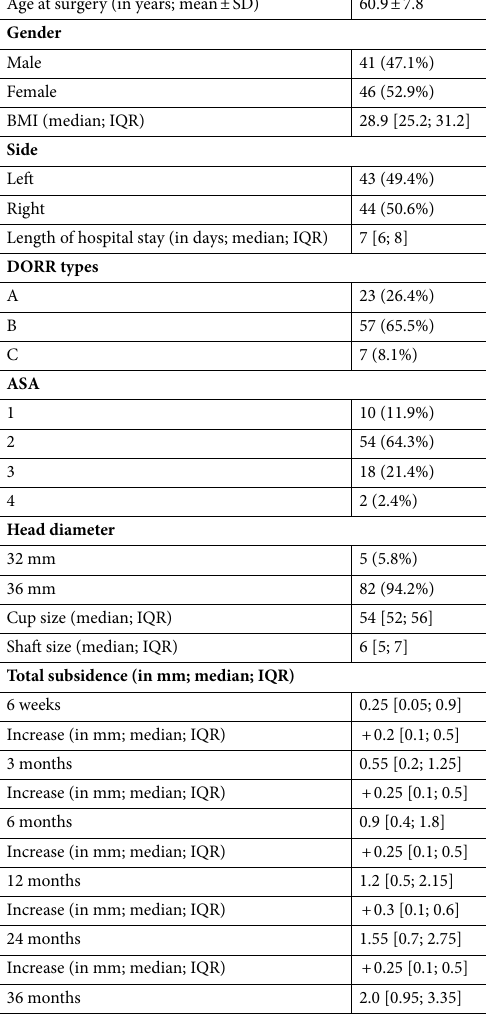
Table 1. Patient characteristics of the study cohort (n = 87). SD Standard deviation, BMI Body mass index, IQR Interquartile range.